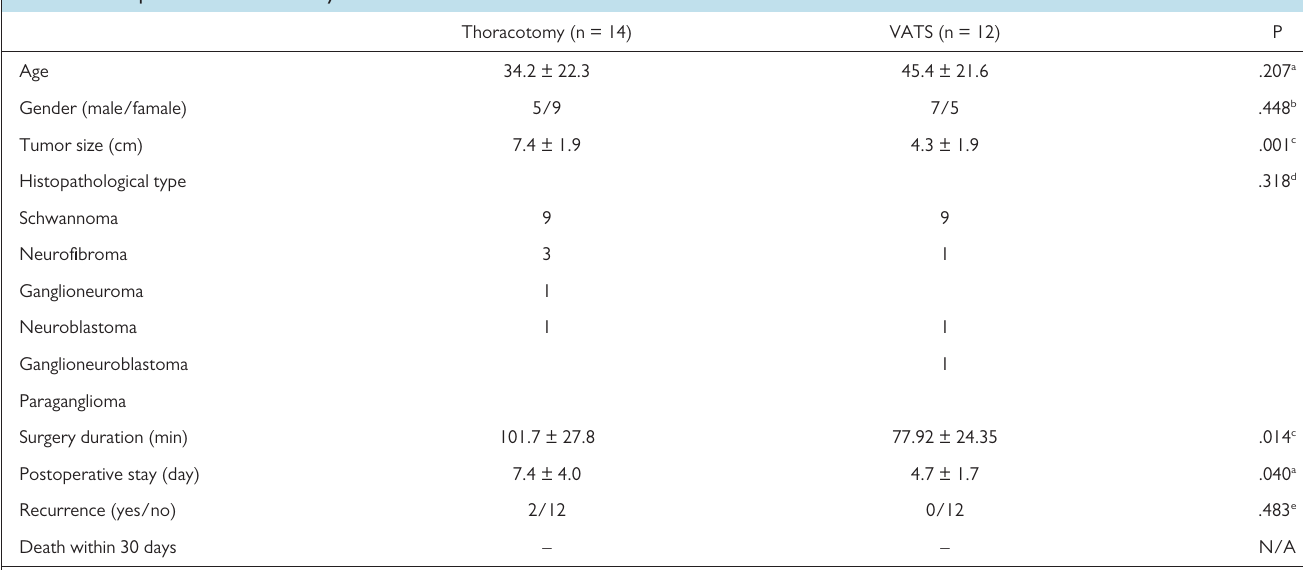
Figure 2. A well-circumscribed lesion on the left is seen on posteroanterior chest radiography in a 59-year-old female patient (A). MRI showed a mass lesion with cystic necrotic hemorrhagic changes with an axial diameter of 43 × 51 mm located in the left paravertebral area adjacent to the aortic isthmus and thoracic aorta (B). Paraganglioma was found in the histopathological examination of the case Table 1. Comparison of Thoracotomy and VATS